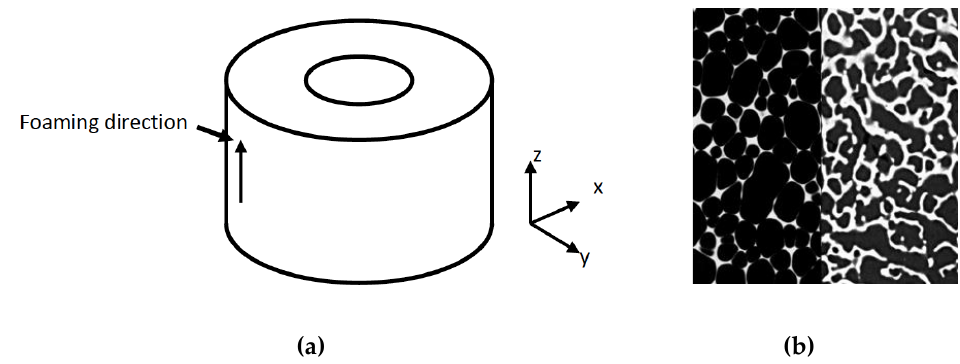
Figure 1. Analogue bone geometry and cellular structure: ( a ) the cylindrical piece of cellular polyurethane foam (density 320 kg · m − 3 ) had an inner diameter of 15 mm, outer diameter of 45 mm, and height 40 mm; ( b ) closed-cell structure of polyurethane foam ( a ) compared with open-cell structure of bovine cancellous bone ( b ).